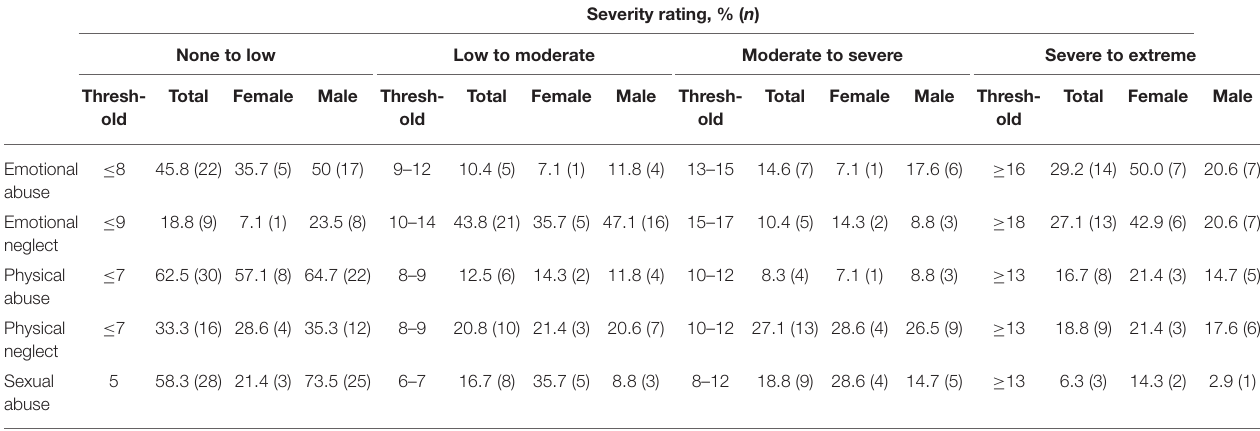
TABLE 3 | Severity thresholds and distribution of childhood maltreatment severity (41) ( N = 48).